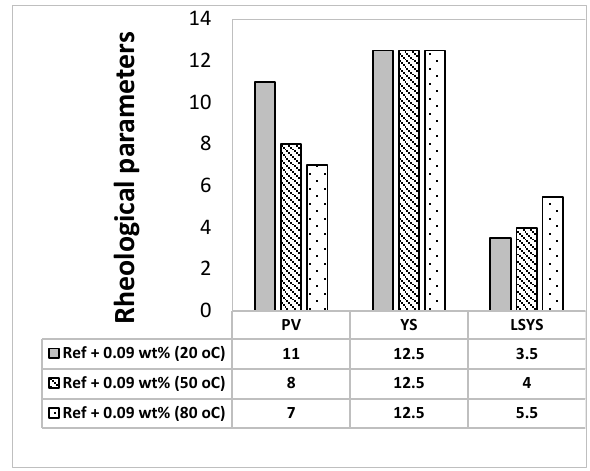
2 -free drilling fluid.